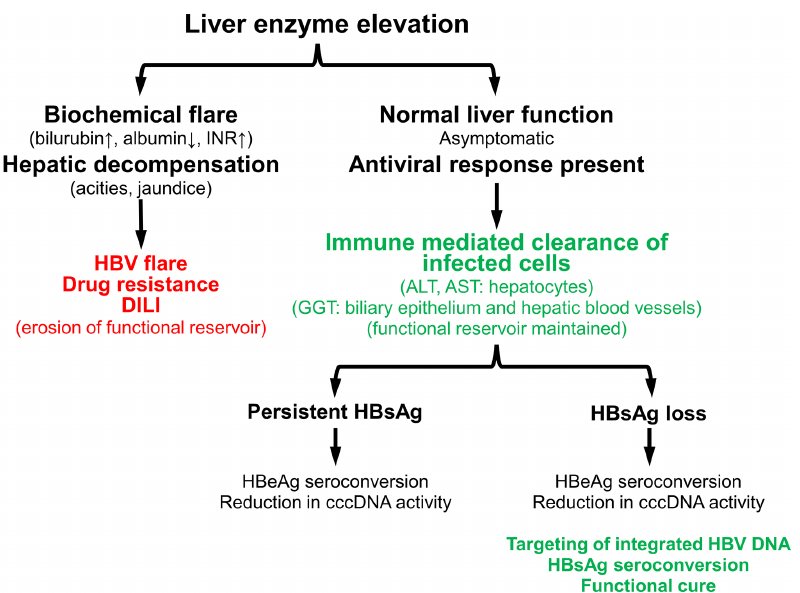
Figure 6. Identification and impact of detrimental and beneficial transaminase flares during the natural history or treatment of chronic HBV